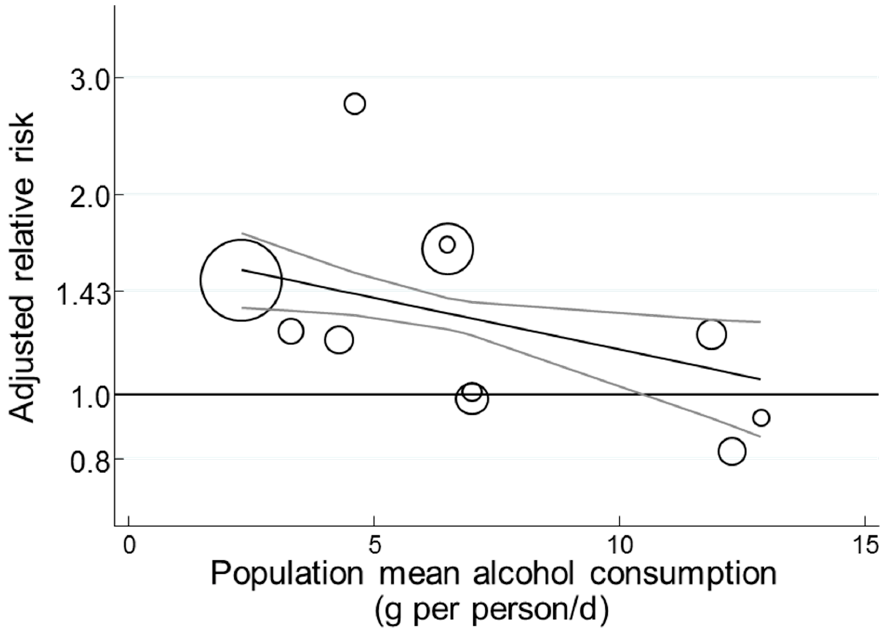
Figure 9. Possible dependence of the size of the T2D–GL risk-relation on the average population ALC consumption. The T2D–GL risk relation shown is per 80 g / d GL in a 2000 kcal (8400 kJ) diet. The negative slope was significant ( p = 0.039, n = 11 studies). Circles represent individual study relative risks and have a size proportional to the study weight (larger circles: Greater weight). Lines show the trend and 95% CIs. Risk relations were adjusted for covariates (CORR, ethnicity (ETH), and duration of follow ‐ up in years (FUY) defined in Section 3.3.14) while the population mean ALC intake was centered on 7g/d: These intakes were: Villegas et al. (2007) (2.3 g/d) [46], Schulze et al. (2003) (3.3 g/d)